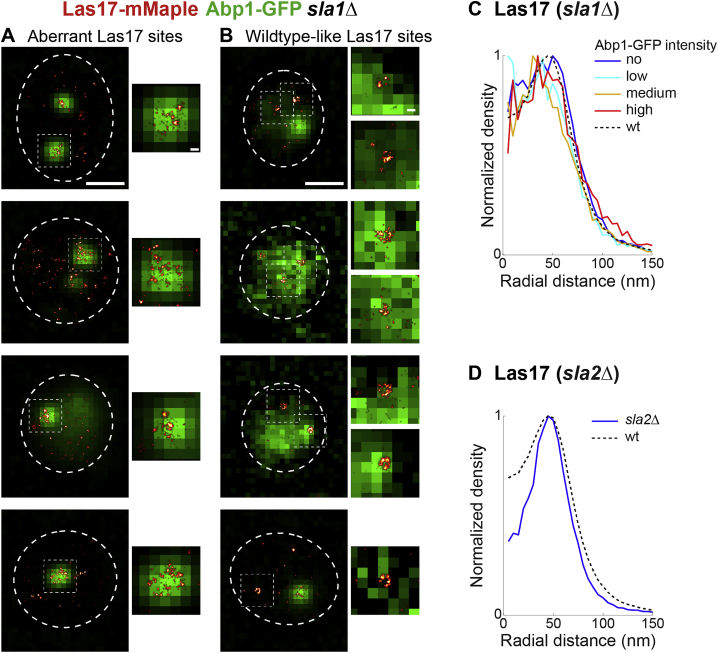
Las17 Structures in sla1Δ Cells, Related to Figure 4(A and B) SLA1 deletion leads to strong changes in Las17 structures. Shown are example sla1Δ cells expressing Las17-mMaple and Abp1-GFP. We note that the large majority of cells showed Las17 in large cluster-like structures (A), while a small subset contained Las17 structures that were similar in size to wild-type (B).(C) Shows radial profiles of Las17 in sla1Δ cells for different Abp1-GFP intensities (compare Figures 3J–3L).(D) Shows radial profile of Las17 in sla2Δ cells. Scale bars 1 μm or 100 nm (zoomed regions).